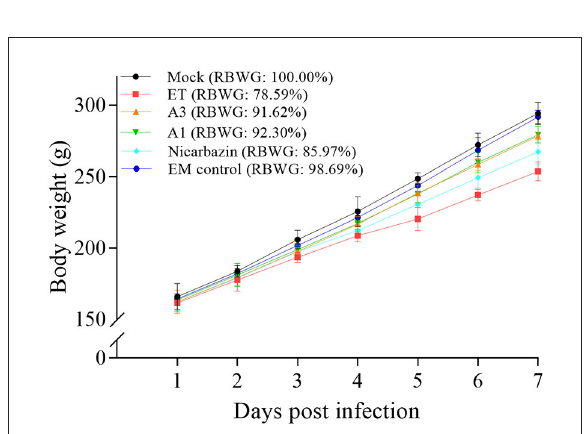
FIGURE5 Evaluation of chicken RBWG in vivo from Day 1–7 p.i. A3 and A1 represent EM treatment 3 days before and 1 day after ET infection, respectively. EM, extract and essential oil mixture (non-toxic concentrations of Punica granatum L., Plantago asiatica L., Bidens pilosa L., Acalypha australis L., Pteris multifida Poir, and Portulaca oleracea L. sp. Pl. extracts and Artemisia argyi Levl. et Vant. and Camellia sinensis [L.] O. Ktze essential oils); ET, Eimeria tenella ; RBWG, relative body weight gain.